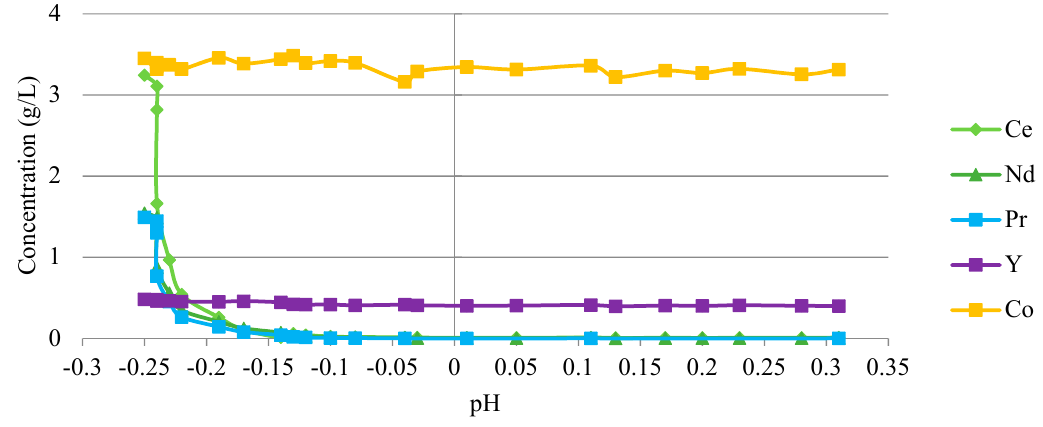
Figure 9. Concentration of Co, Ce, Nd, Pr and Y vs pH after addition of NaOH.